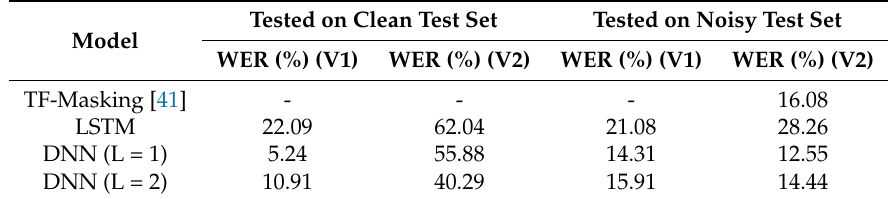
Table 8. WER of deep models trained on noisy